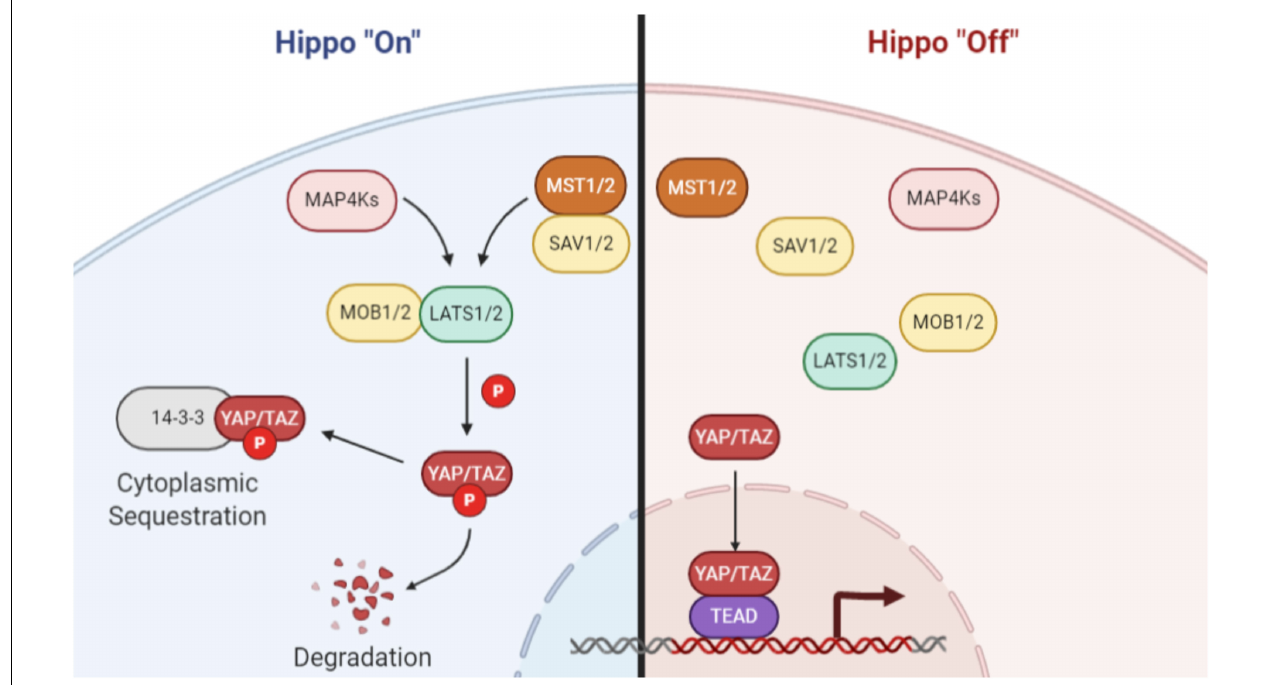
FIGURE 1 | Canonical Hippo signaling. When Hippo signaling is activated, MAP4 kinases or the MST1/2 kinases phosphorylate and activate the LATS family of kinases. The MST/LATS interaction is facilitated by MOB and SAV adaptor proteins. Activated LATS kinases subsequently phosphorylate the YAP and TAZ paralogs, which then associate with 14-3-3 proteins and are sequestered in the cytoplasm or degraded. When Hippo signaling is inactive, YAP/TAZ are not phosphorylated and are free to translocate to the nucleus, where they act as coactivators of transcription through interaction with TEAD family and other transcription factors. Image created with